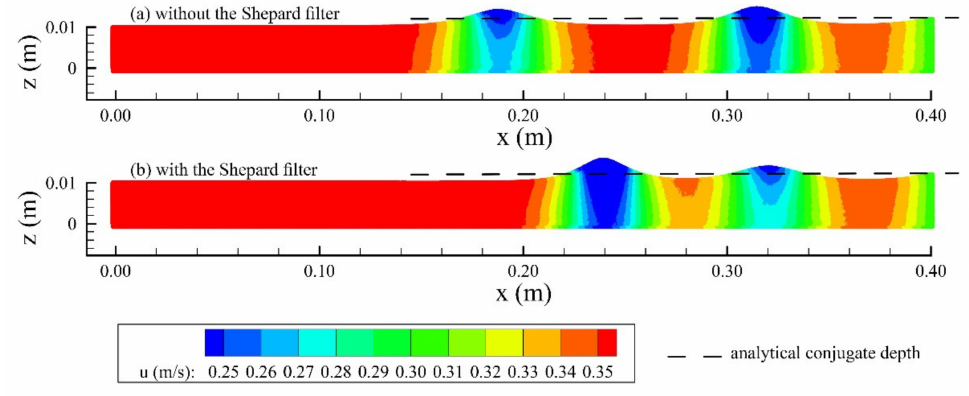
Figure 7. Velocity fields of case 1 at t = 15.96